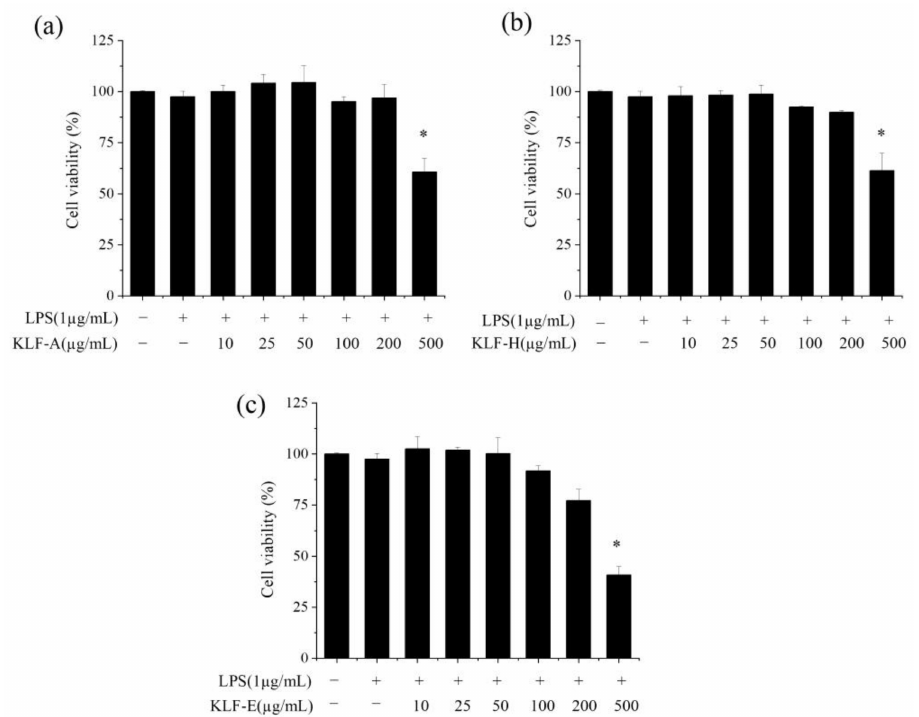
Figure 1. Effect of three krill lipid fractions with different concentrations on the cell viability of RAW264.7: ( a ) KLF-A, ( b ) KLF-H and ( c ) KLF-E. Blank group refers to the untreated cells and its viability was taken as reference (100%); cells treated with LPS alone were considered as the control group. * p < 0.05 versus the control group; one-way analysis of variance (ANOVA) combined with Games–Howell test was used to analyze the significance. Abbreviations: − , no addition; +, addition; LPS, lipopolysaccharide; KLF-A, the krill lipid fraction extracted with acetone in the first step; KLF- H, the krill lipid fraction extracted with hexane in the second step; KLF-E, the krill lipid fraction extracted with ethanol in the third